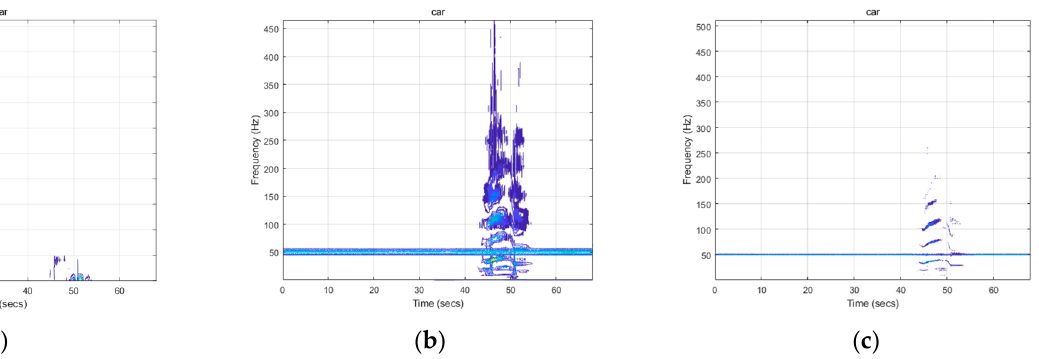
Figure 10. Draw spectral contour lines for STFT, CWT, SSWT; ( a – c ) are spectral contour lines for SFFT, CWT, and SSWT.